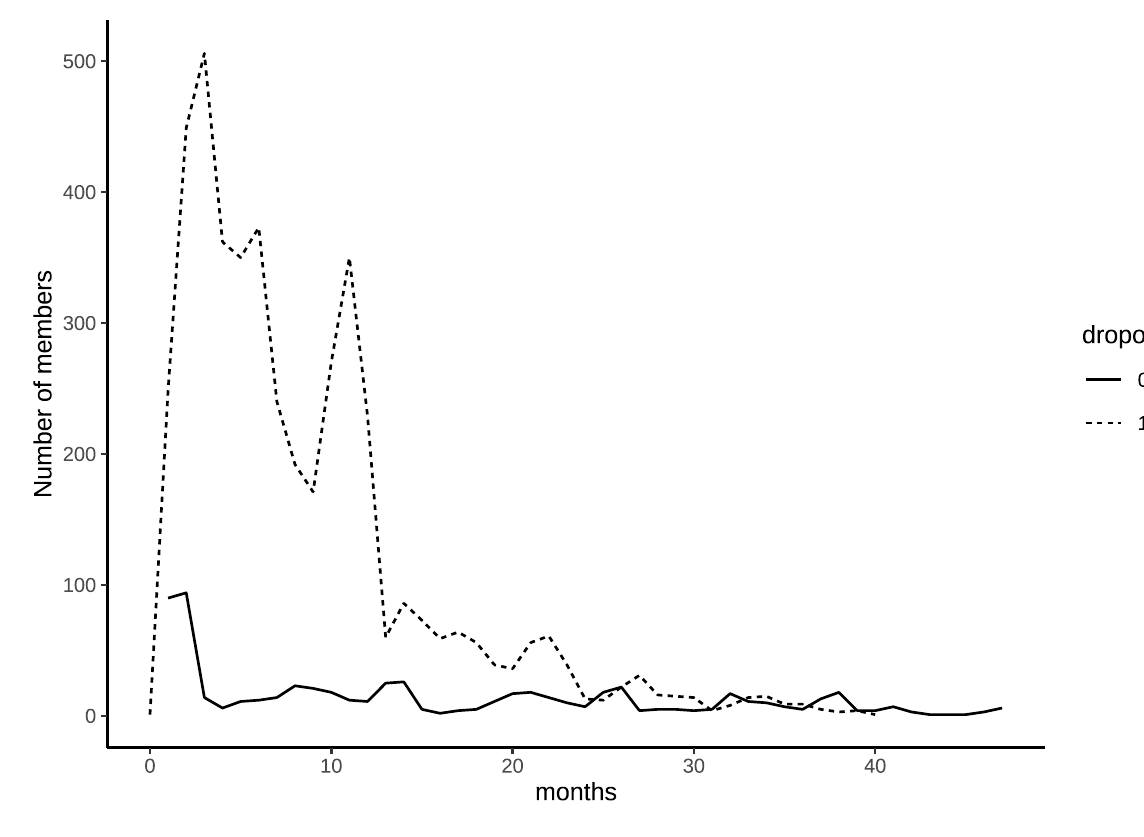
Figure 1. Number of members per month. Table 1. Summary statistics of features